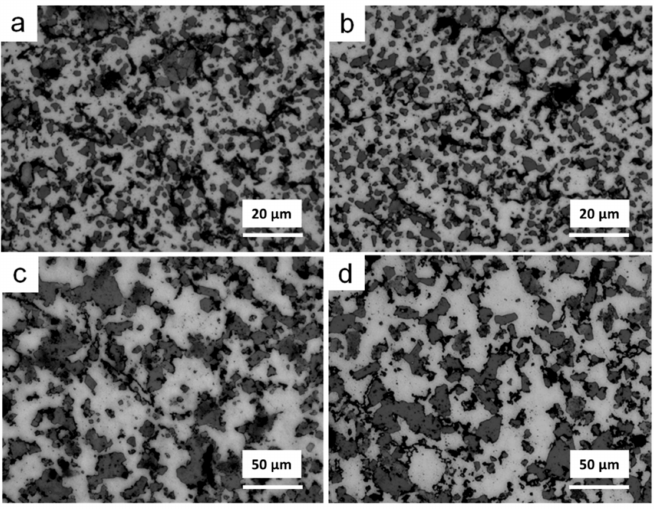
Figure 7. Optical microstructures of parts sintered at ( a ) 530 ◦ C; ( b ) 550 ◦ C; ( c ) 570 ◦ C; and ( d ) 590 ◦ C for 1